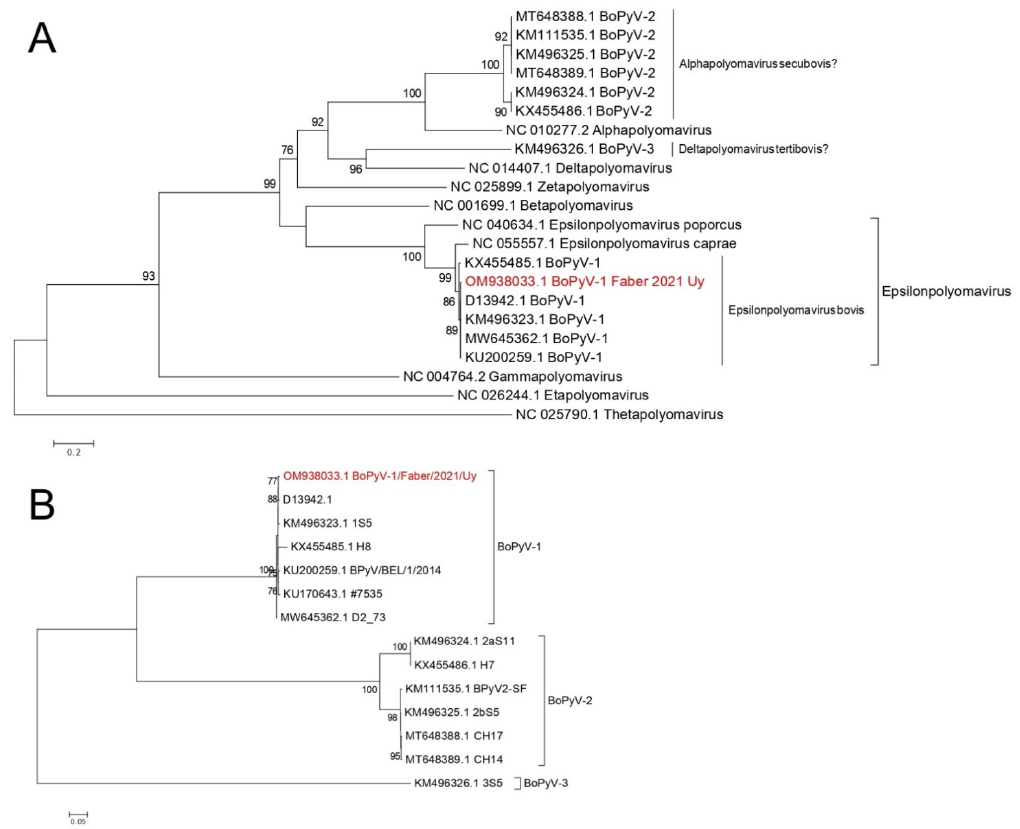
Figure 5. Phylogenetic analyses. ( A ) Phylogenetic tree for LT antigen amino acid sequences. Repre- sentative sequences of all ICTV recognized genera, all polyomavirus sequences of bovine origin from GenBank, and the sequence obtained in this work (in red font) were used. Sequences were aligned with ClustalW. The best substitution model (rtREV+F+I+G4) and the maximum likelihood